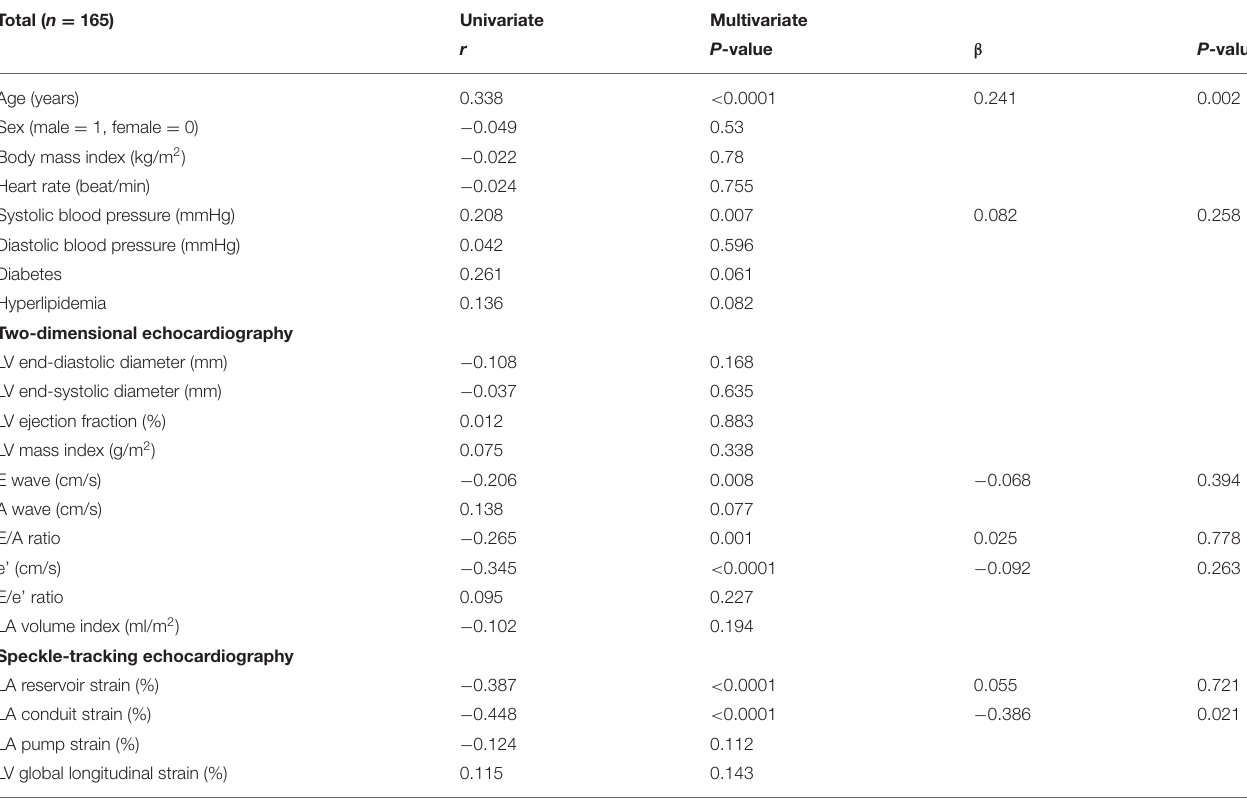
TABLE 3 | Univariate and multivariate analyses of the association of cardio-ankle vascular index with clinical variables and echocardiographic